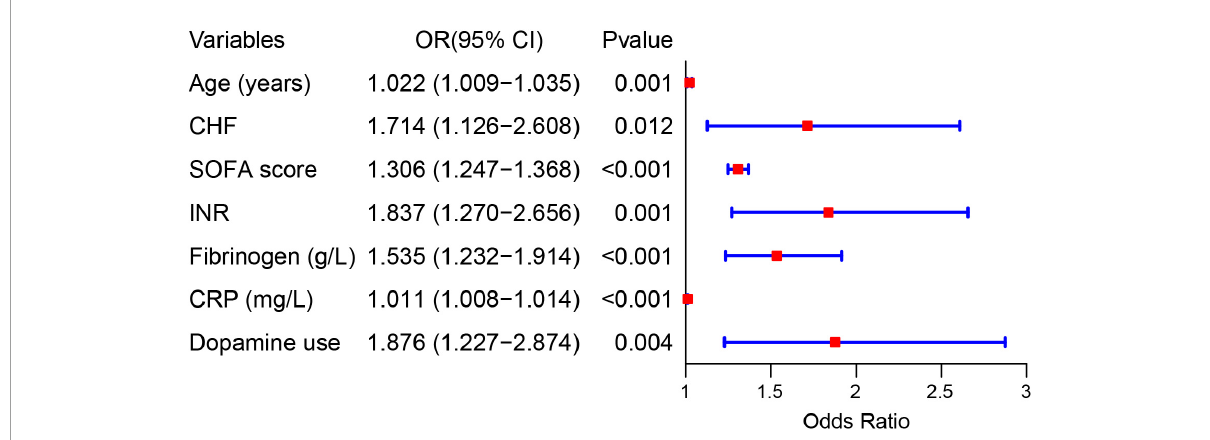
FIGURE3 Forest plot showing the relationship between risk factors and the development of new-onset atrial fibrillation in patients with sepsis.